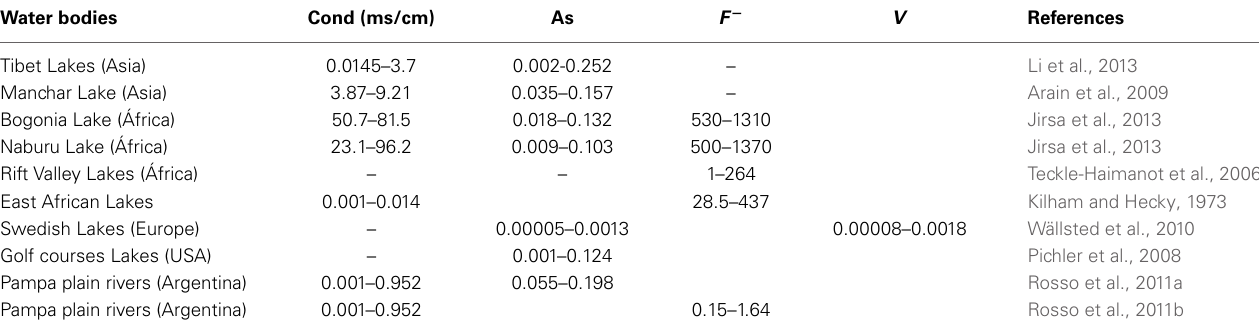
Table 5 | Arsenic (As), fluoride (F − ), and vanadium (V) concentrations (minimum-maximum values in mg/L) in surface water of different water bodies of the